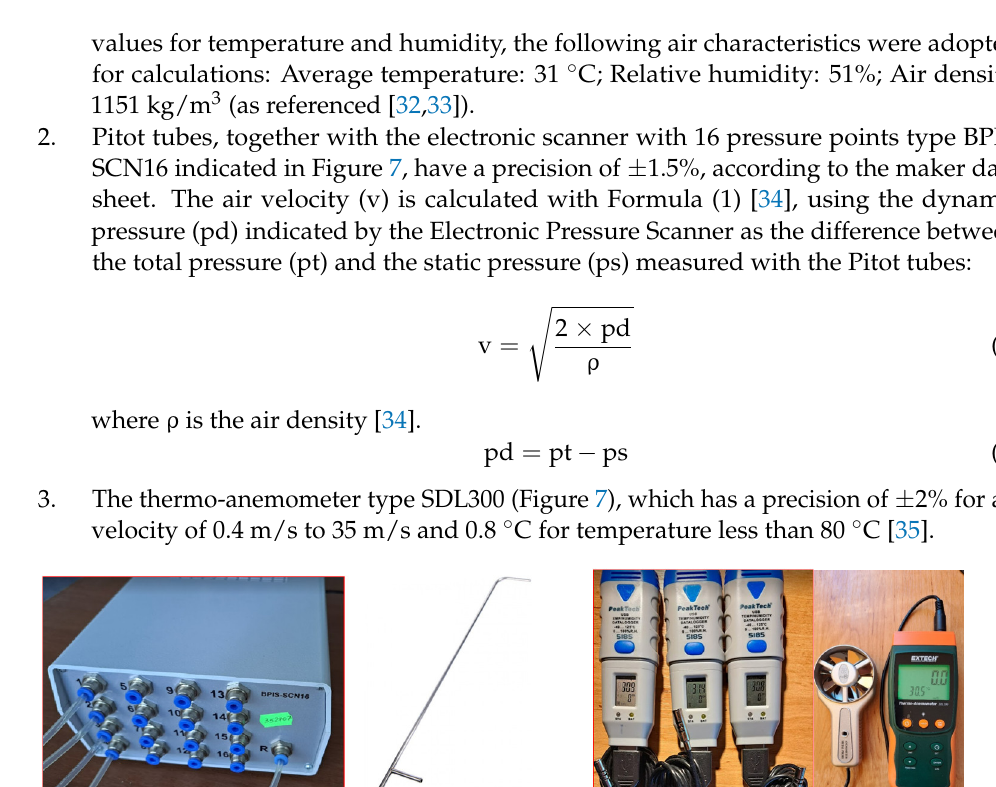
where ρ is the air density [34].